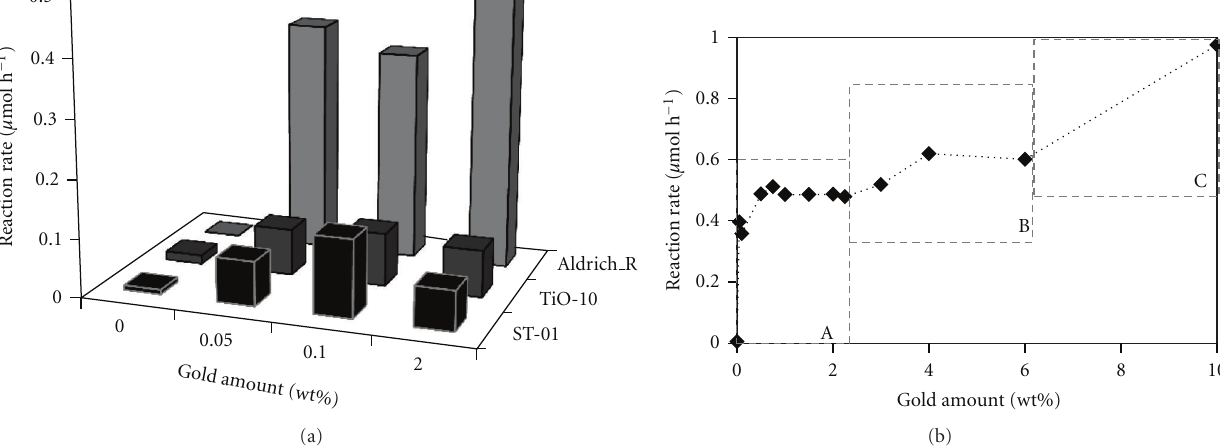
Figure 12: Dependence of deposited gold amount on acetone generation during visible light irradiation on Au/TiO 2 : ST-01, TIO-10, and Aldrich R. (b) Detailed dependence for Au/TiO 2 : Aldrich